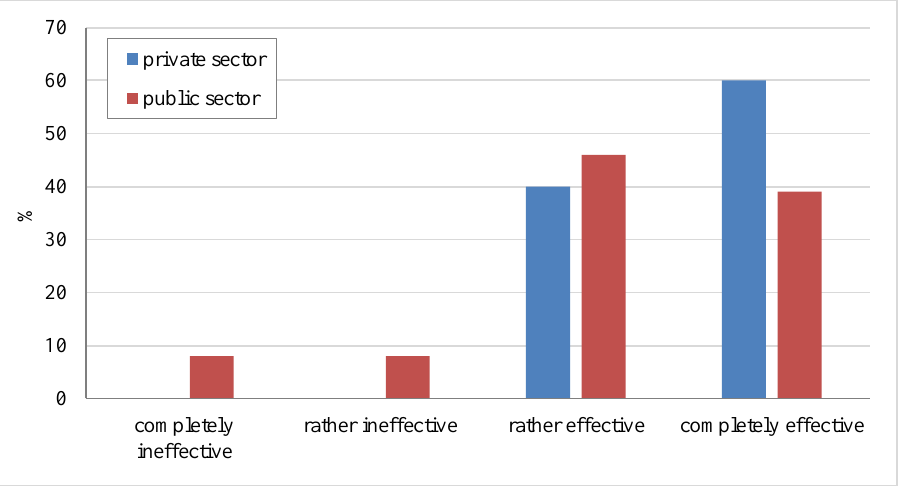
Figure 2. How effective will your current teamwork come to